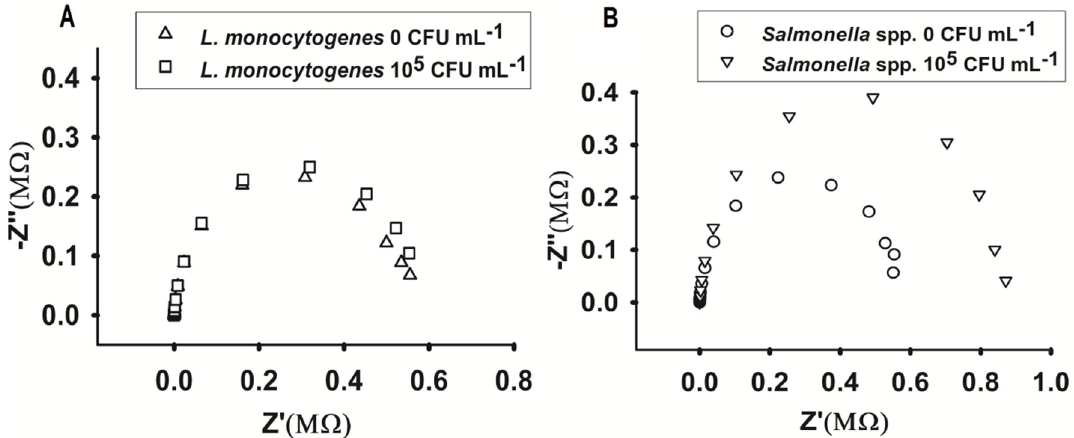
Figure 4. Nyquist plots of ( A ) L. monocytogenes , ( B ) Salmonella spp. Both analyses were performed at a concentration of 10 5 CFU mL − 1 .